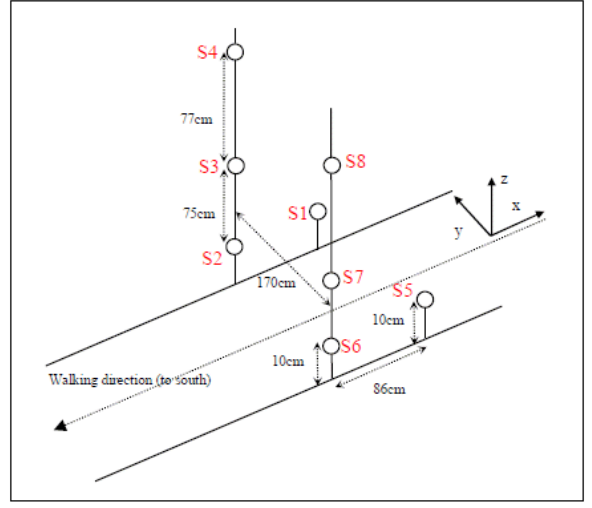
Figure 1. Schematic view of the check point. The relative distance between the sensors are